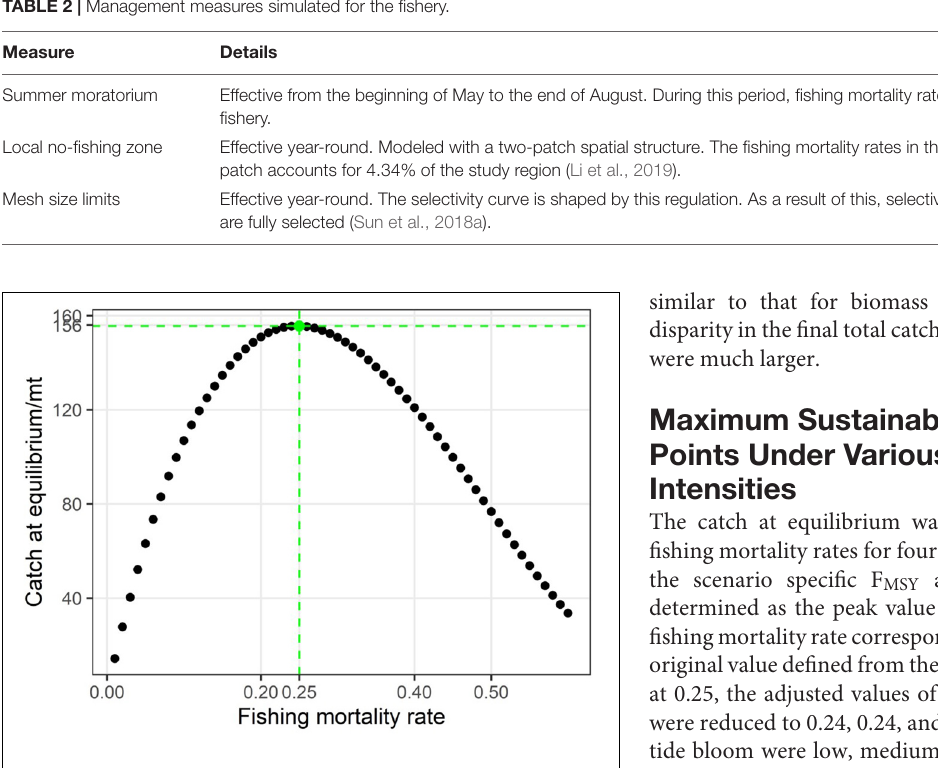
FIGURE 4 | Catch at equilibrium under different fishing mortality rates for the simulated fishery without green tide blooms. The maximum sustainable yield (MSY) and F MSY are identified as the peak of the curve indicated by the green